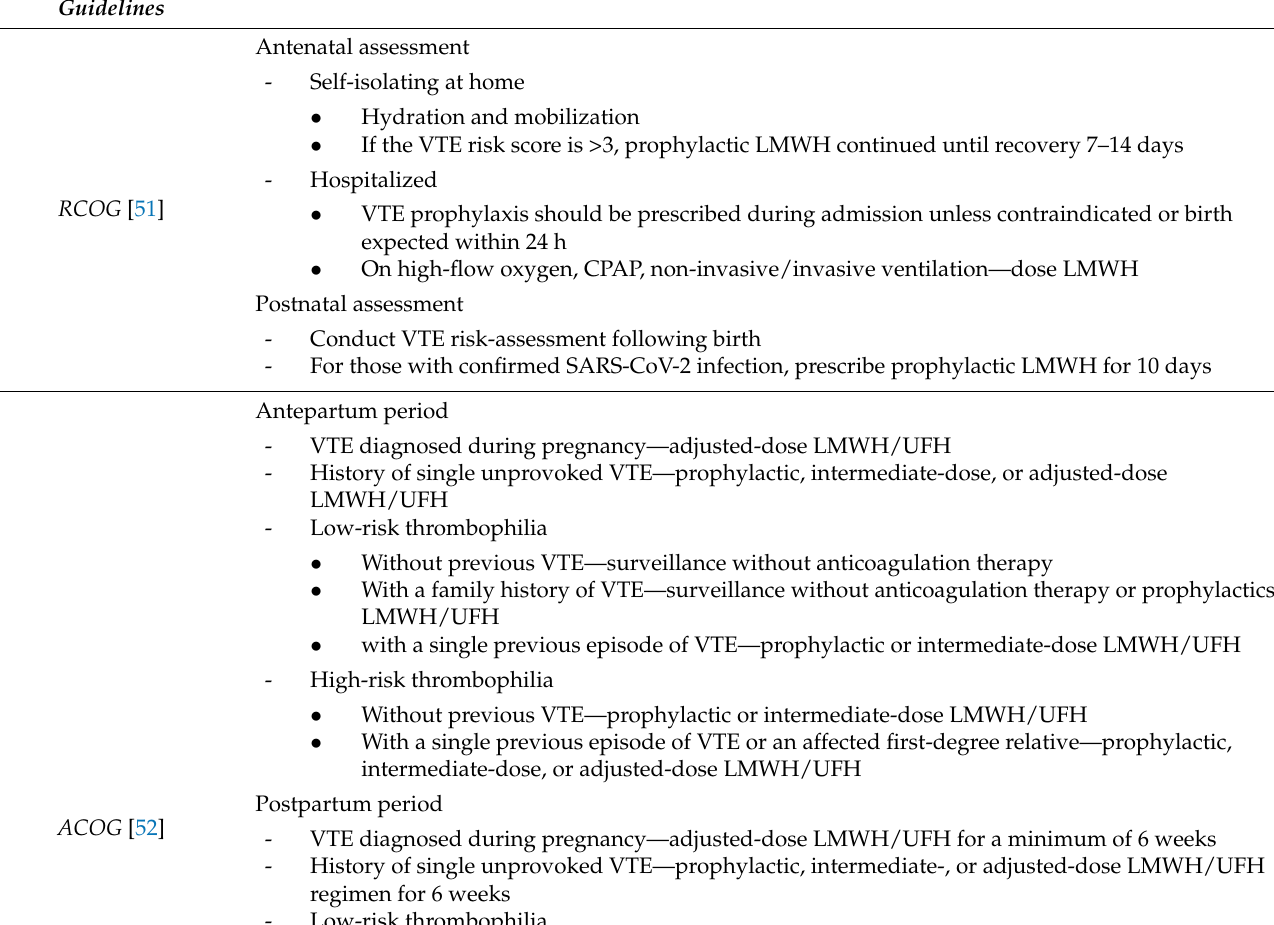
Table 1. Synopsis of guidelines from international societies on thromboprophylaxis in pregnant women with